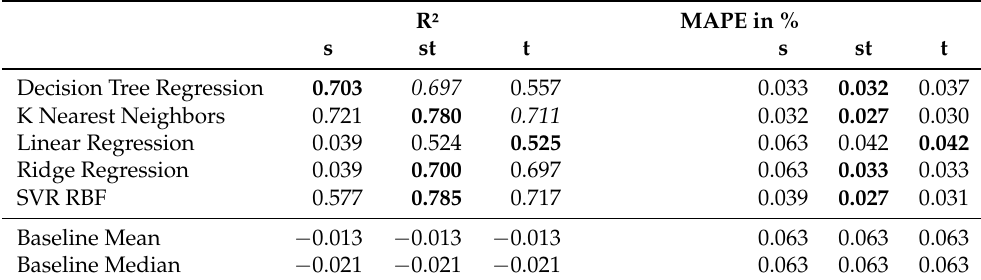
Table 7. Stacking Box Data Set I: results for Target Distance B. The differences in comparisons of st or t vs. s were tested for significance, using the Wilcoxon signed-rank test ( α = 0.05): where the test did not confirm significant differences, the respective st or t values are printed in italic. The highest R 2 and the lowest MAPE are shown in bold for each algorithm. R² MAPE in % s st t s st t Decision Tree Regression 0.703 Linear Regression Ridge Regression SVR